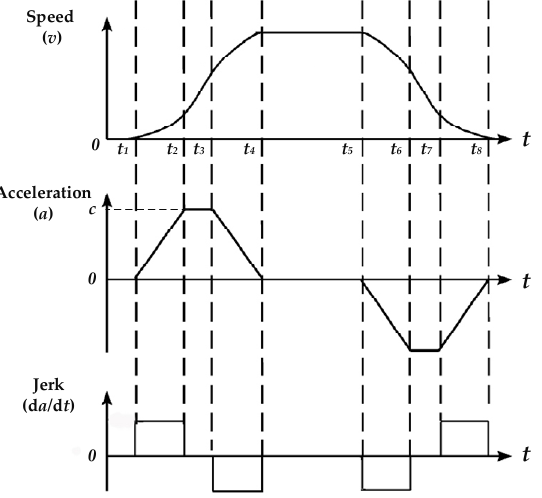
Figure 2. The timing diagram of the stepper motor used in the flipping device. The red LED with a parallel light plane is chosen as the light source because the